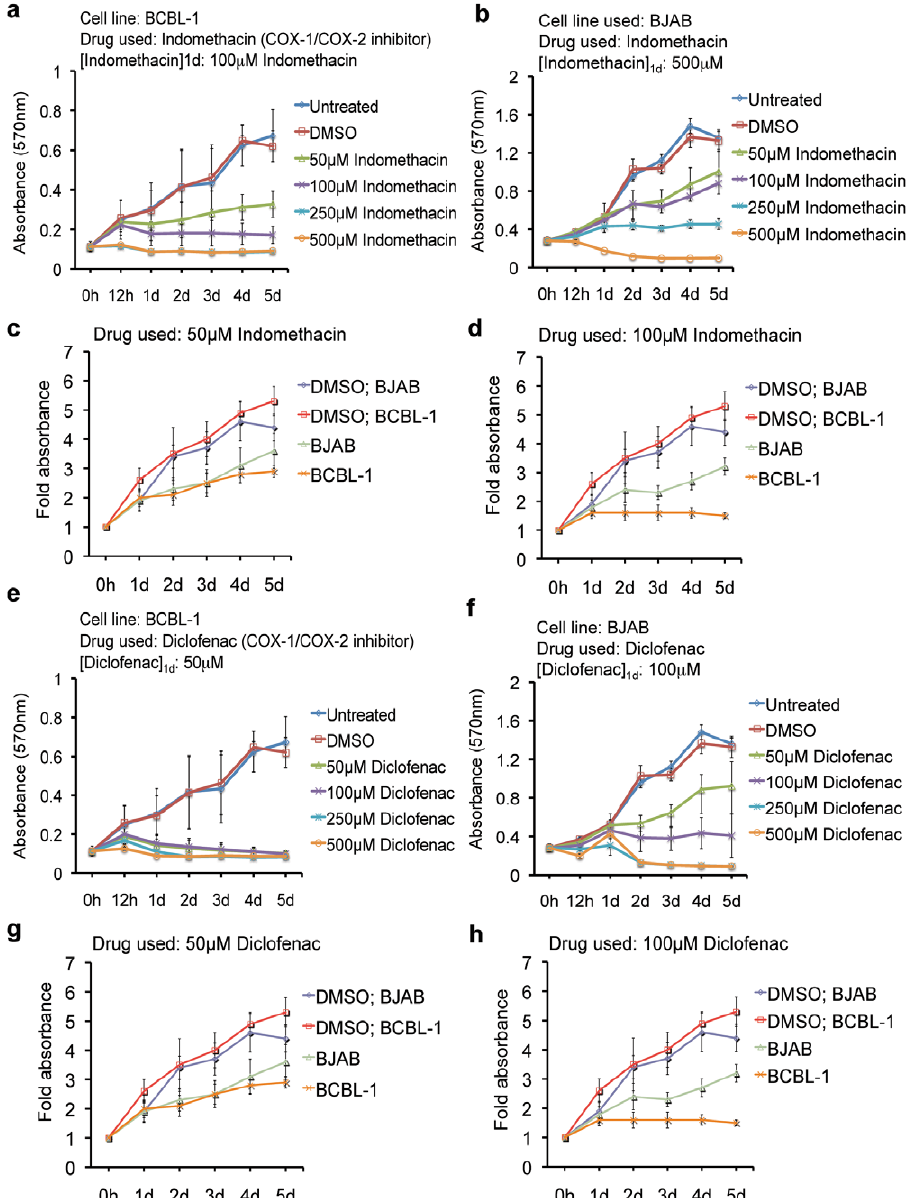
Figure 2. Sensitivity of KSHV + PEL cells to COX-1/COX-2 inhibitors. ( a–h ) 5 6 10 5 BCBL-1 or BJAB cells were seeded with the indicated concentrations of COX-1/COX-2 inhibitors indomethacin ( a–d ) and diclofenac ( e–h ), DMSO ( a–h ) or left untreated ( a–h ). Cell proliferation was measured by MTT assay at 0 h, 1d, 2d, 3d, 4d, and 5d. The cells were neither replenished with fresh media nor supplemented with the drugs. ( c, d, g, h ) Plots comparing the proliferation rate of BCBL-1 and BJAB cells treated with 50 m M and 100 m M of indomethacin and diclofenac at 1d, 2d, 3d, 4d, and 5d. The fold absorbance was calculated with respect to the untreated (UN) control before treatment. ( a–h ) One-way ANOVA with Tukey’s posthoc comparison analysis (p , 0.05) was used to determine whether the drug treatment induced a statistically significant difference in the proliferative indexes at 1d, 2d, 3d, 4d, and 5d compared to untreated cells of the respective cell lines. Indicated on the graphs are the concentrations of each drug that had a significant effect at 1d ([drug] 1d ). Each reaction was done in quadruplicate, and each point represents the average 6 S.D. from four independent experiments.